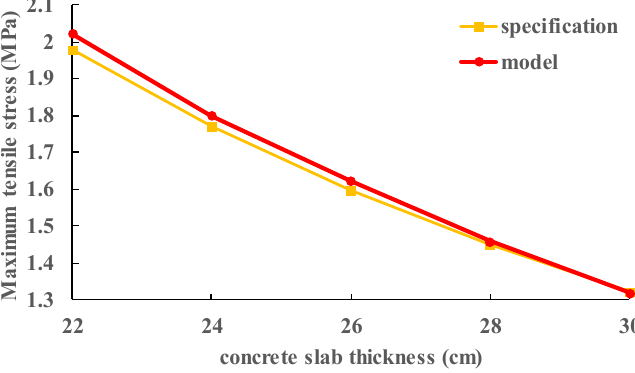
Figure 6. Comparison of results of model and standard.